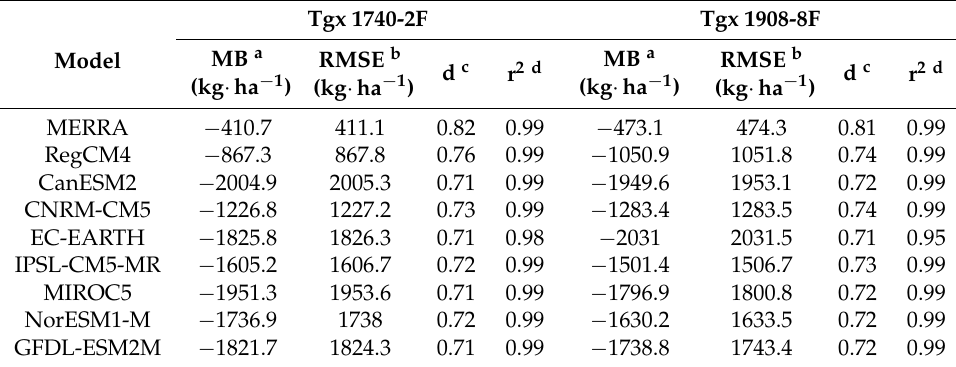
Table 7. Statistical parameters for the relationship between observed and modeled soybean yield using Tgx 1740-2F and Tgx 1908-8F RegCM4 data 1990–2010, MERRA 1980–2010, CORDEX-Africa 1980–2010 and the meteorological observed dates of 1980–2010 used to compared with the